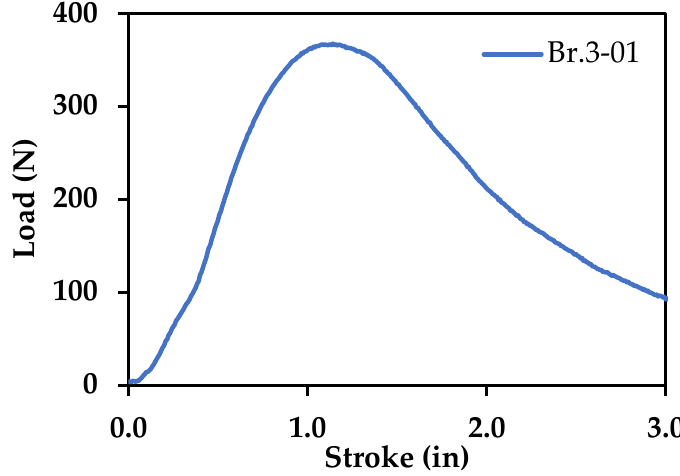
Figure 12. Data obtained from a three-point flexural test on Br-PLA.